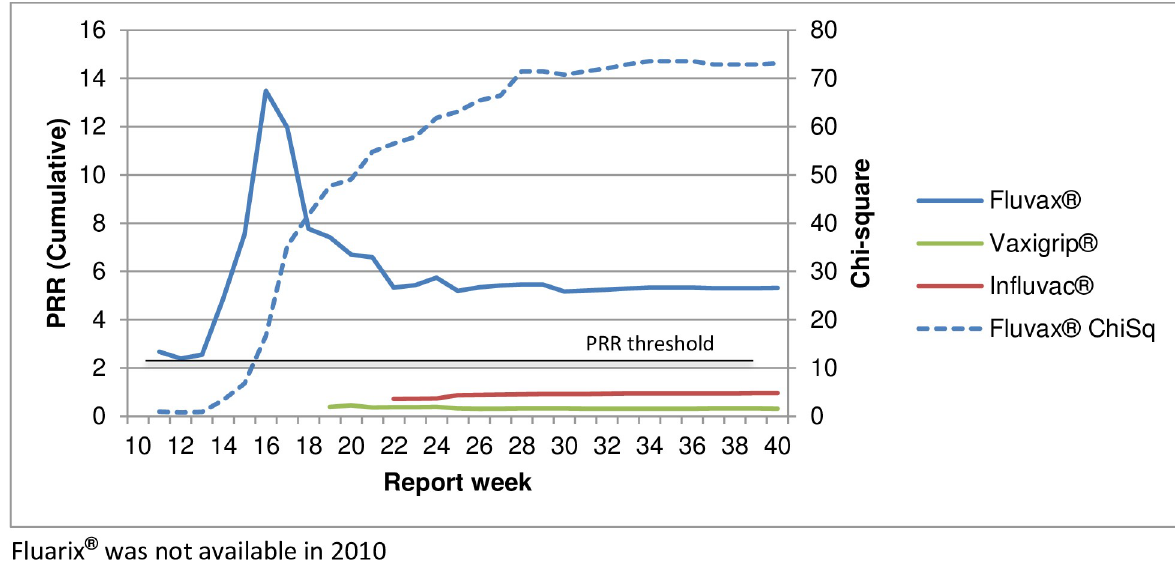
Fig 7. PRR by influenza brand to other infleunza vaccines, fever AEFI, 2010.